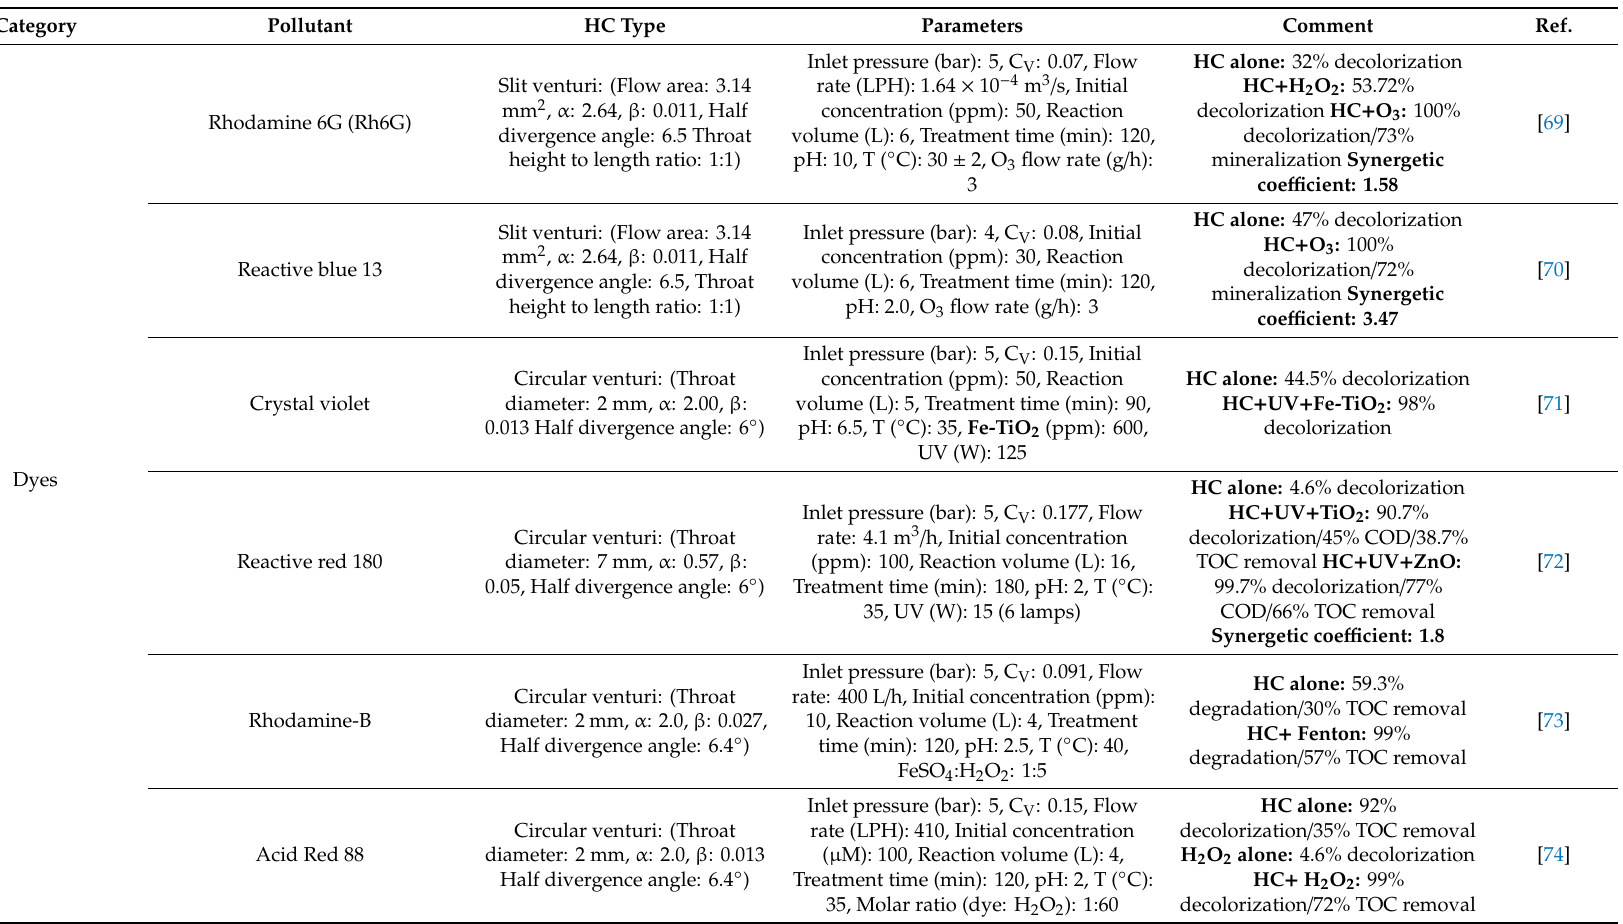
Category Parameters Comment